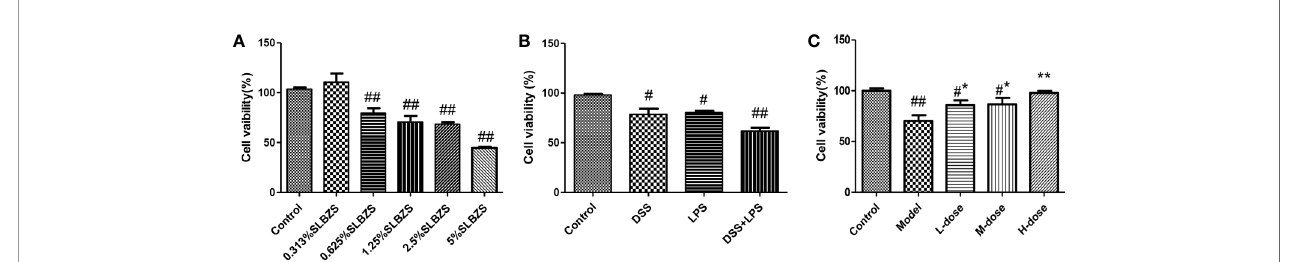
FIGURE 5 | Effects of SLBZS on the viability of MCME cells. (A) MCME cells were cultured for 24 h in 0.313%, 0.625%, 1.25%, 2.5% and 5% SLBZS medium, and the viability of each group was measured by the MTT assay. (B) The MCME cells were cultured for 24 h in medium containing 10 m g/ml DSS or 1 m g/ml LPS, and the viability of each group was measured by the MTT assay. (C) The cells were cultured in 10 m g/ml DSS for 2 h, and then the supernatant was discarded, the cells were washed with PBS, and 1 m g/ml LPS was added to the medium for 12 h. Subsequently, the viability of each group was measured by the MTT assay. The data are shown as the mean ± S.E.M. # P < 0.05, ## P < 0.01 vs. the control group; * P < 0.05, ** P < 0.01 vs. the model group.